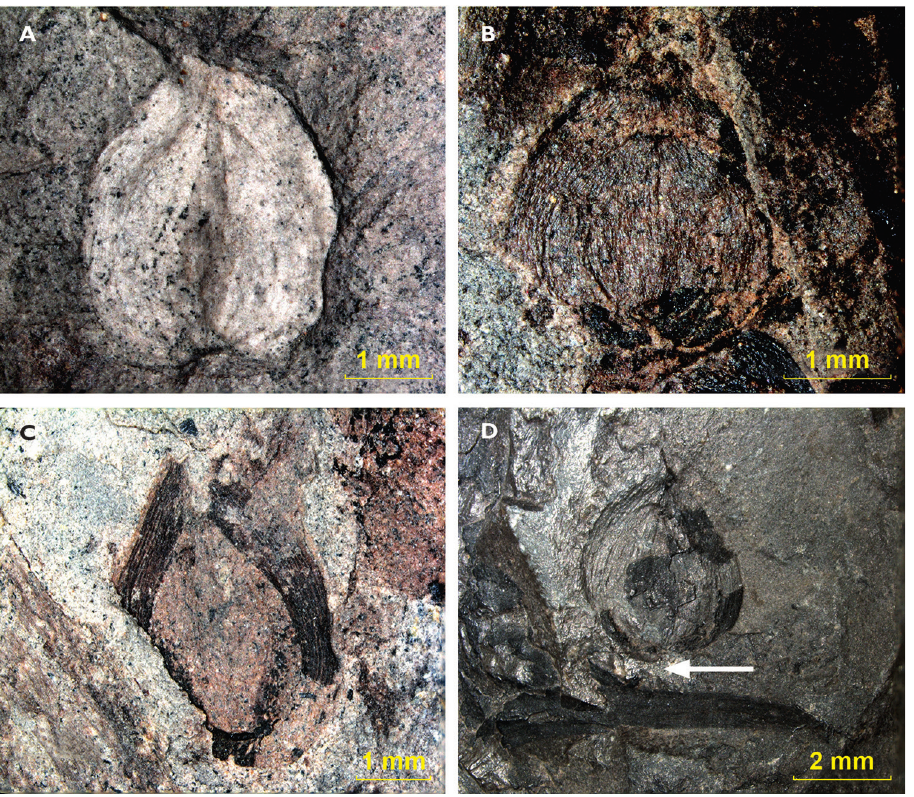
Figure 10. Seeds: A Seed with notched chalaza, sample 1529, Mt Pelé B Striate seed with visible pollen chamber, sample 75, Mt Pelé C Seed with visible micropyle, sample 75, Mt Pelé D Seed possibly on first leaf segment, sample 1362, Ronchamp (arrow indicates interrupted organic